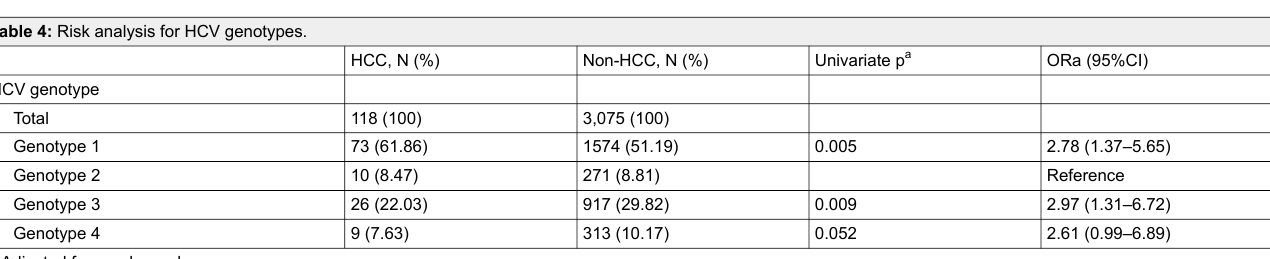
Table 4: Risk analysis for HCV